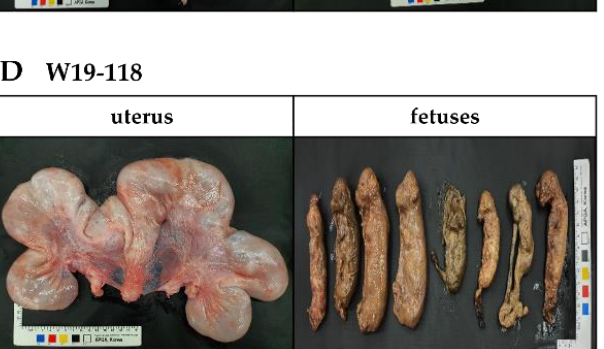
Figure 3. Pathogenicity of PPV1-190313 in three gestational Yukatan miniature sows. Sows were infected with 8 mL of the PPV1-190313 strain (at 4.0 × 10 5 [TCID 50 ]/mL); 4 mL was administered by intramuscular injection into the neck, and the other 4 mL was delivered intranasally via a spray. ( A ) HA assay results obtained with PPV1-190313 after 40 passages in porcine kidney-15 cells. ( B ) Pho- tographic and hematoxylin and eosin staining images of the uterus from the W19-090 sow, which miscarried during the experiment. Photographic images of the uterus and fetuses of sow W19-117 ( C ) and sow W19-118 ( D ).